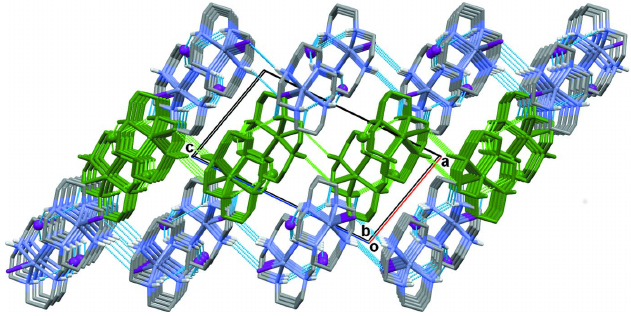
Figure 3 The packing in I viewed down the b -axis direction. Hydrogen-bonding interactions are shown as dashed lines.